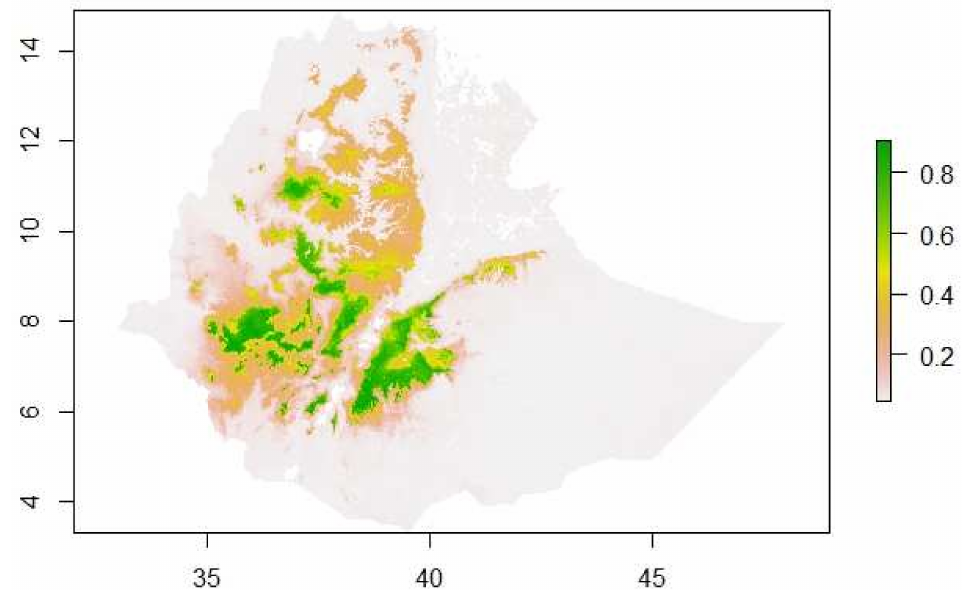
Figure 4. Predicted habitat suitability of highland bamboo in Ethiopia under future conditions, SSP2-45 scenario, from the mean of the three